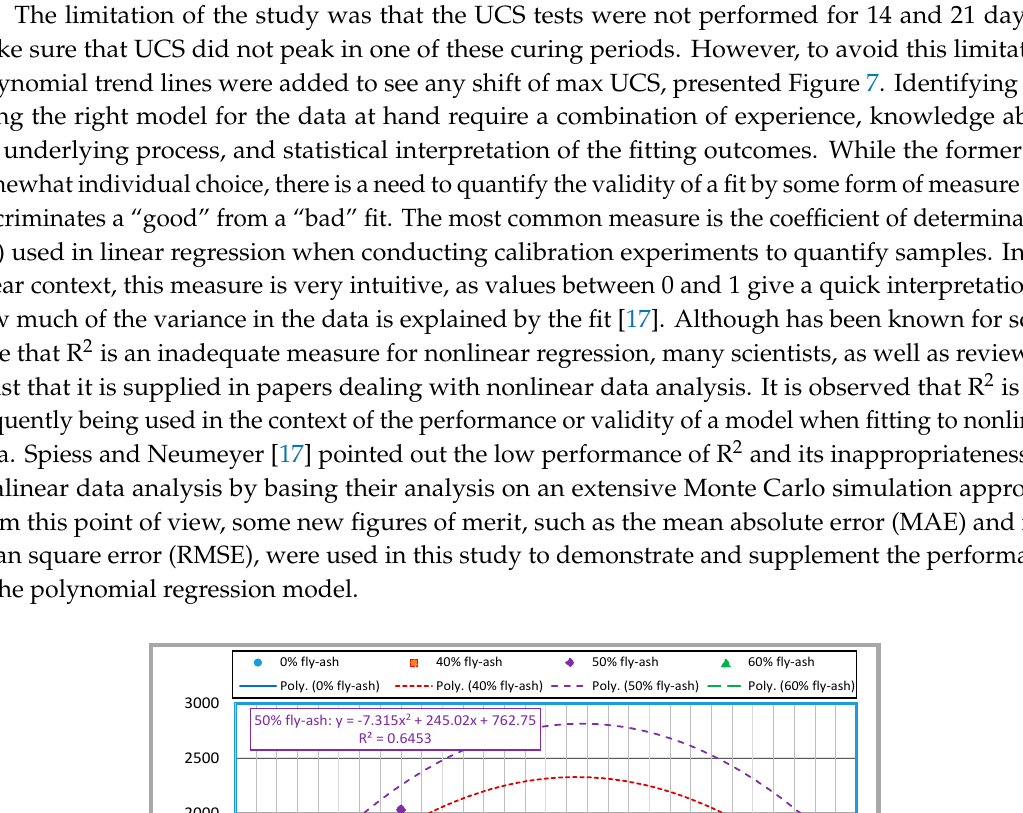
Figure 6. Variation of UCS with curing period.